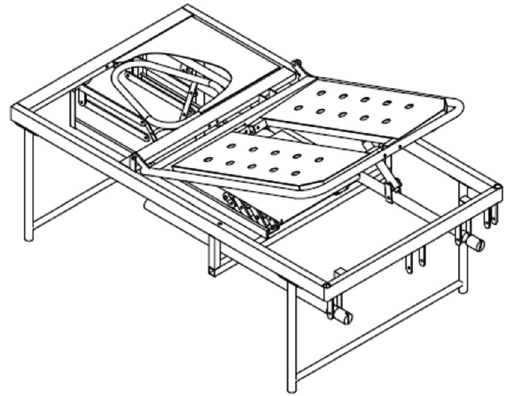
Fig. 6 Another view of raised backrest position